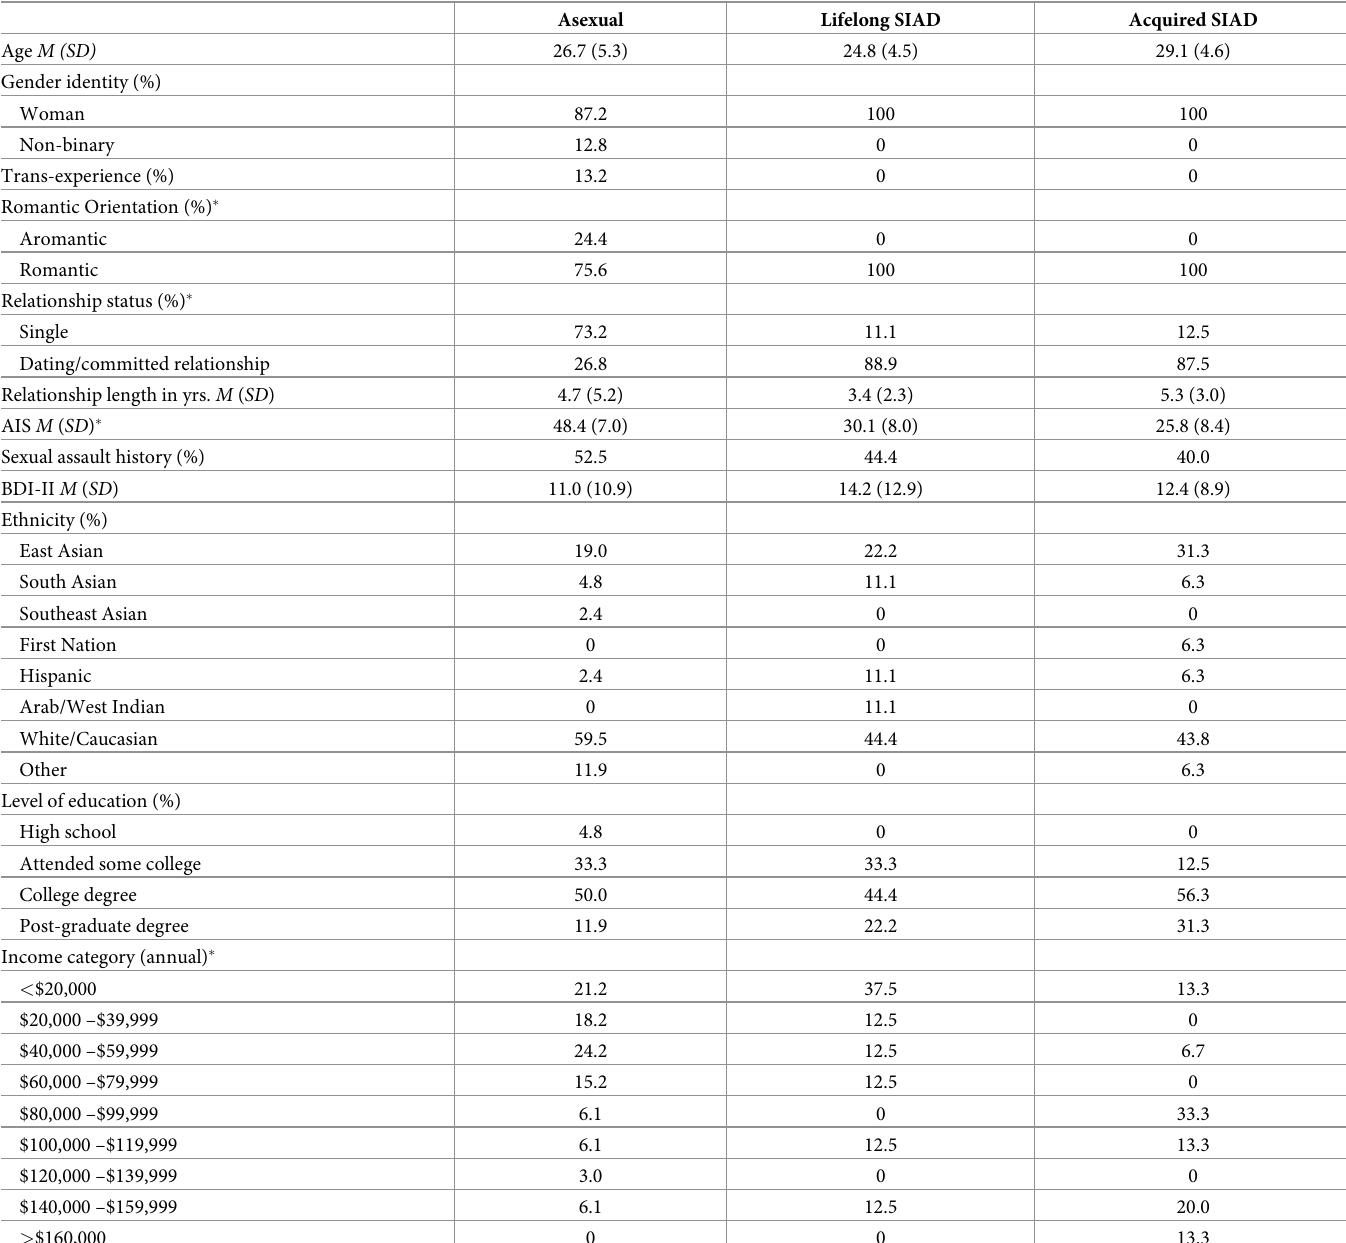
Table 2. Sociodemographic information for participants.